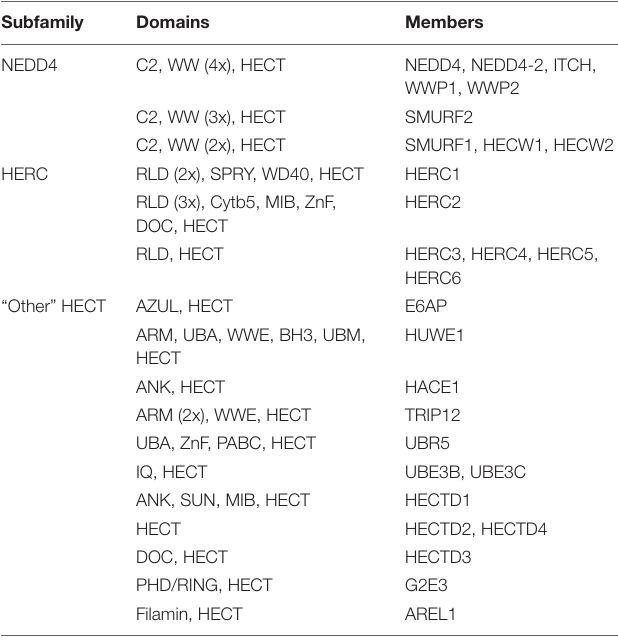
TABLE 1 | Overview of the human HECT E3 ligase subfamilies with the respective members, including their domain